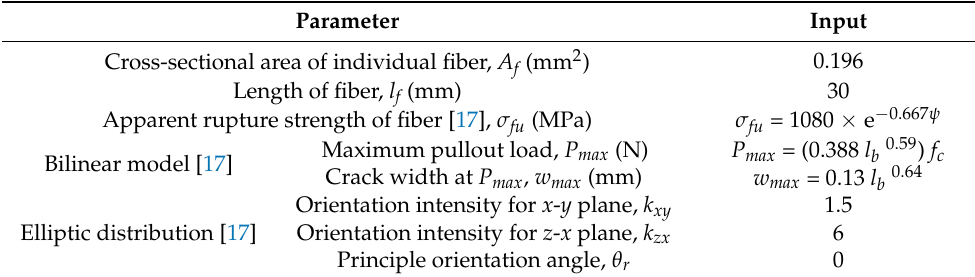
Table 5. Parameter input values for bridging law calculation.